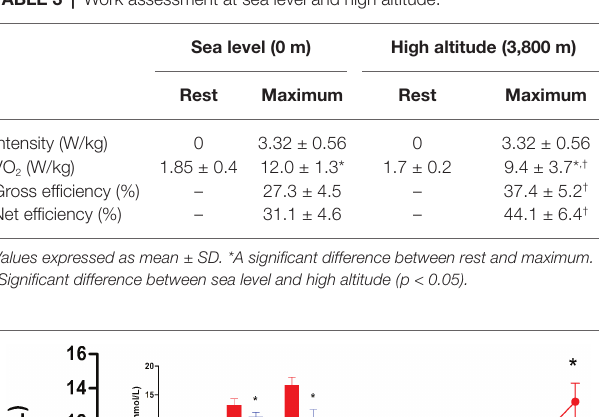
TABLE 3 | Work assessment at sea level and high altitude.